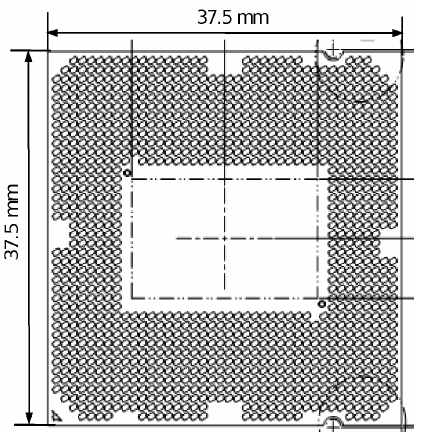
Figure 2. Enabling Test Board.